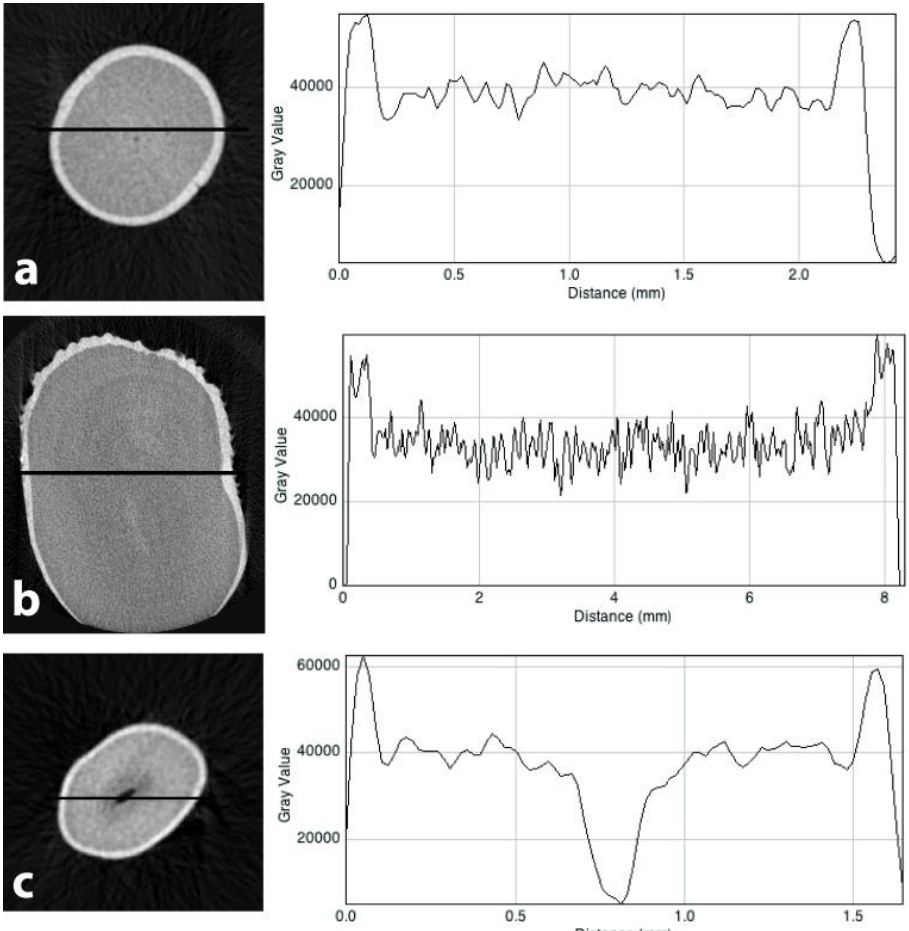
Fig. 6. Reconstructed Micro-CT cross-sections of extant odontocete teeth and greyscale value/distance profile. a) Striped dolphin Stenella coeruleoalba (UFSC 1344) . b) Amazon river dolphin Inia geoffrensis (IEPA 1899) . c) Franciscana Pontoporia blainvillei (UFSC